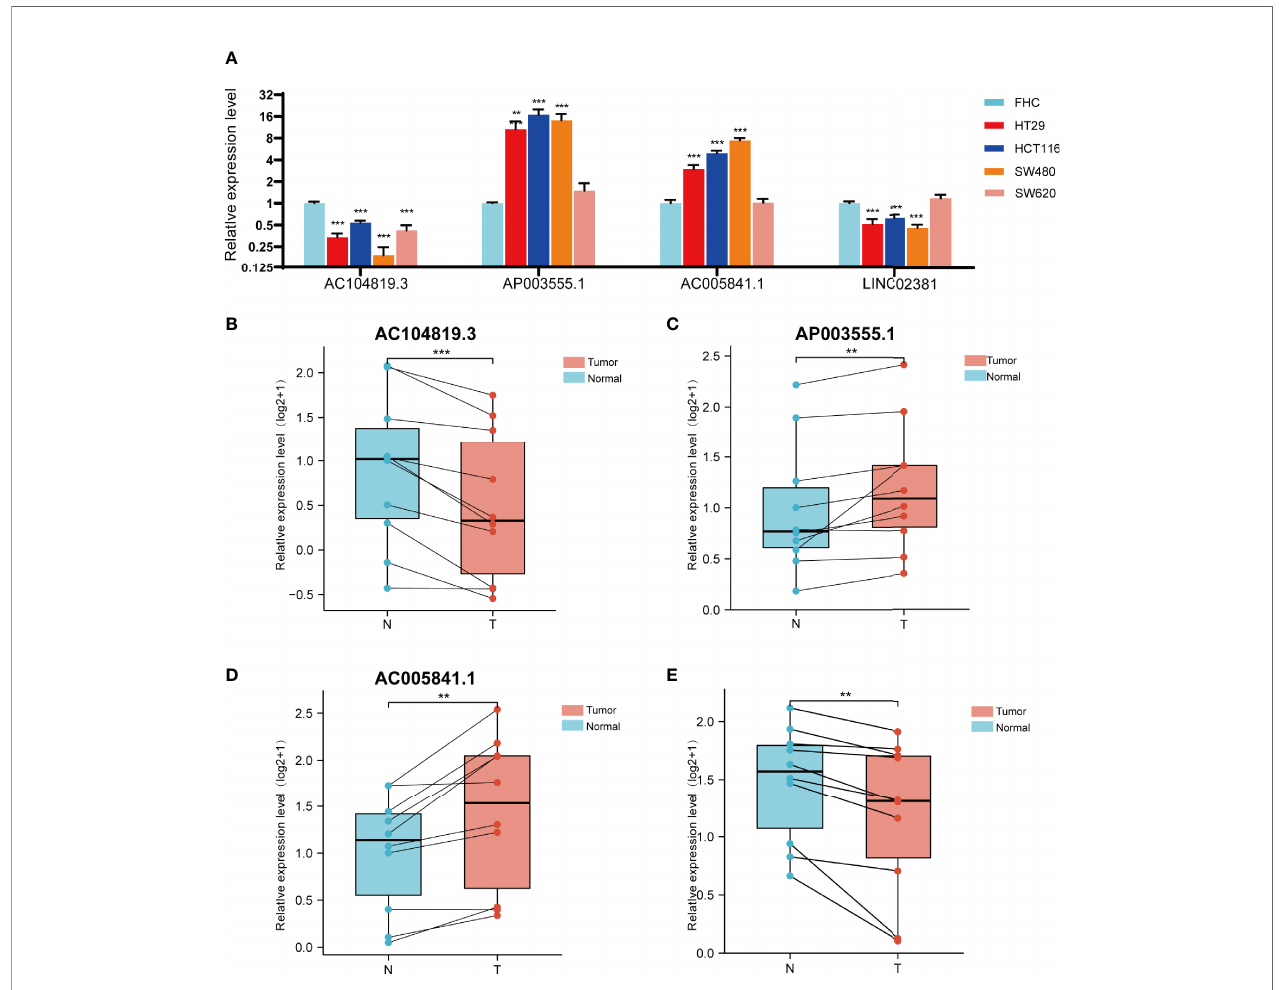
FIGURE 9 | Validation of the expression level of the four ferroptosis-related lncRNAs in cell lines and tissues. (A) Expression analysis of four ferroptosis-related lncRNAs in four colon cancer cell lines (HT29,HCT116,SW480,SW620) with FHC lines (established from normal foetal colonic mucosa). (B – D) Expression analysis of AP003555.1, AC104819.3, AC005841.1 and LINC02381 in 10 pairs of colon cancer tissue samples. **p < 0.01, and ***p <